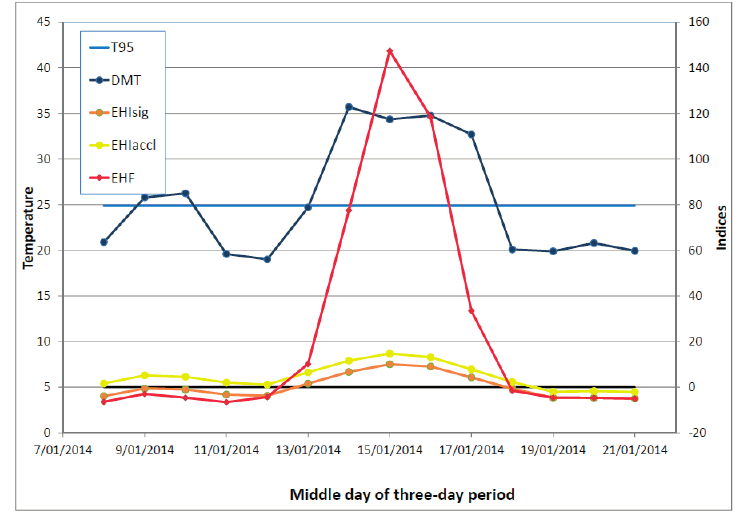
Figure 2. Schematic representation of a short heatwave early in the summer season. The DMT and 95th percentile thereof (both in °C) are plotted against the left hand axis, while the three heatwave indices (in °C and K 2 ) are plotted against the right hand axis. The heatwave indices are plotted against the middle day of the TDP, to facilitate comparisons with the DMT profile. The zero line for the indices is shown as a thick black line. Because of the shortness of the heatwave, the acclimatisation EHI is positive for rather longer than value in the schematic is 30 °C. is the significance EHI. The notional T 95